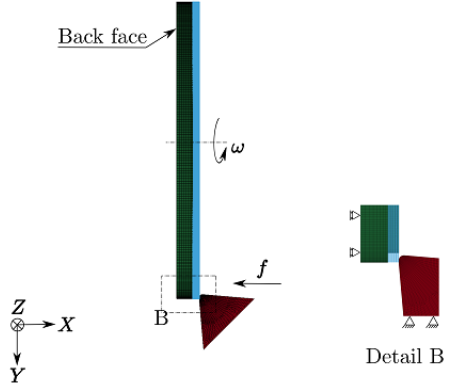
Figure 5. Boundary conditions applied in 3D machining